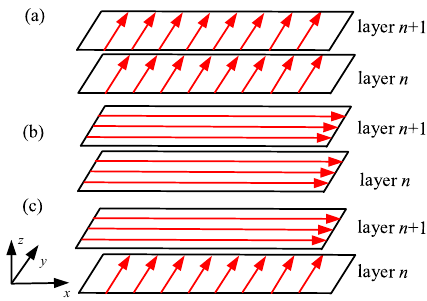
Figure 2. The different scanning strategies used: ( a ) scanning along the y direction (transverse scanning); ( b ) scanning along the x direction (longitudinal scanning); and, ( c ) alternative scanning along the x and y directions in consecutive layers.